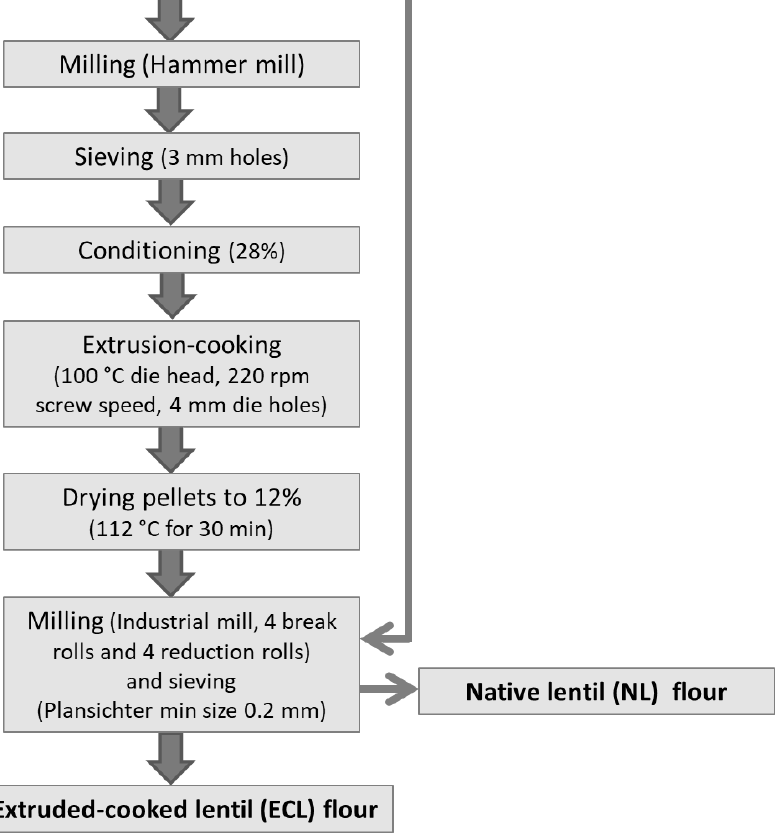
Figure 1. Flow chart of the productive process of native and extruded-cooked lentil flour.